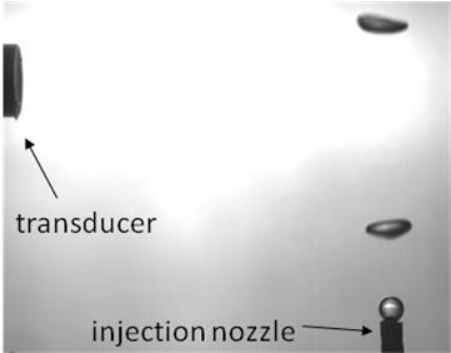
Figure 5. Image sample from high speed filming employed on mean sphere equivalent diameter estimation.